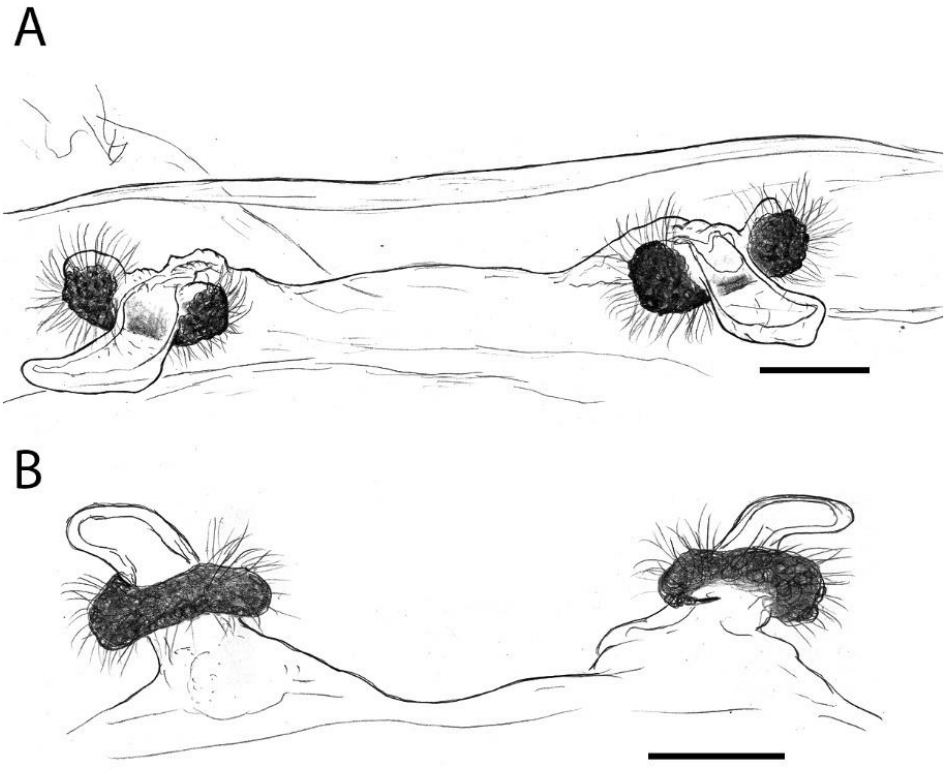
Figure 9. Sahastata aravaensis sp. nov. female endogyne. ( A ): paratype MACN-Ar 41837. ( B ): paratype SMF. Drawings: Ivan L. F. Magalhaes, Scale bars = 100 µm.